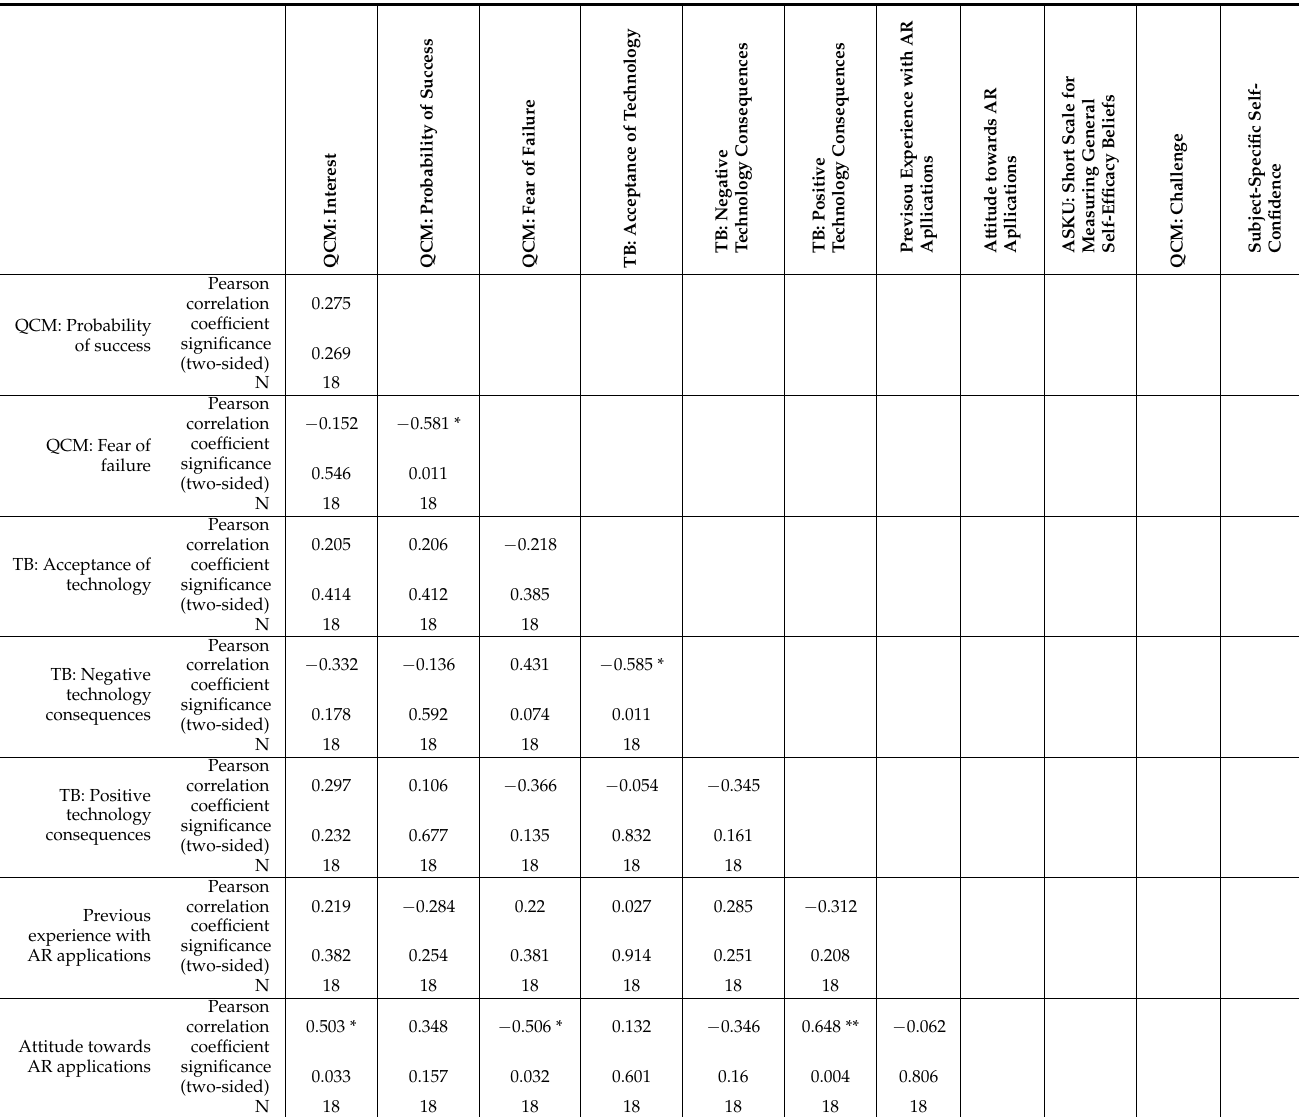
Table 2. Overview of the correlations of the individual scales used in the paper-based